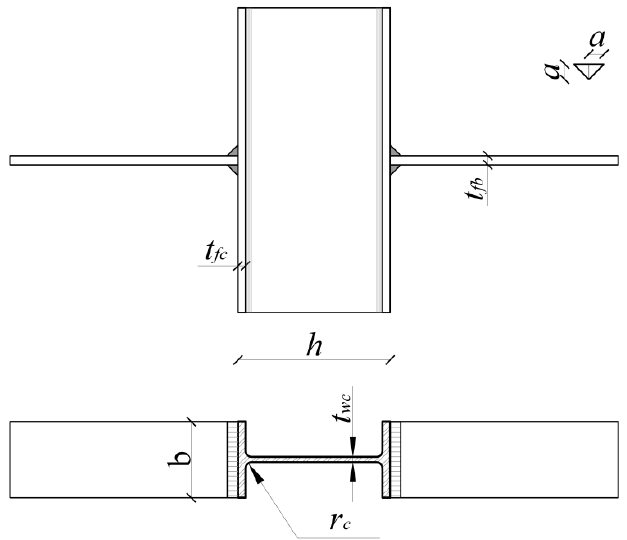
Figure 1. Representation of the geometrical configuration of the specimens tested by Matusiak et al.